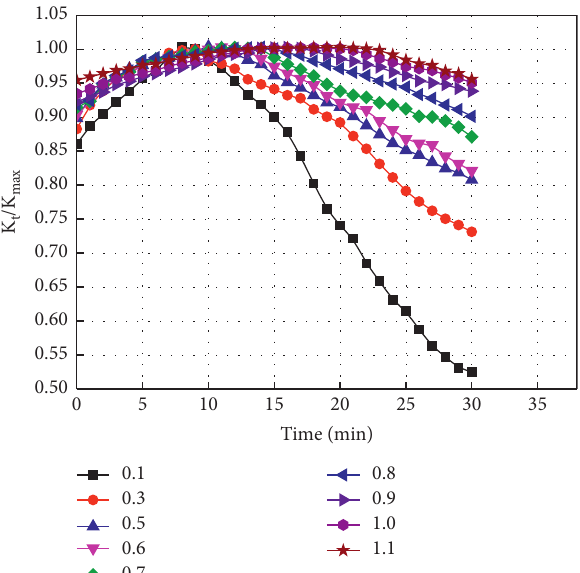
Figure 9: The curve of foam relative conductivity with time under different concentrations of xanthan gum. Table 5: The fitting linear equations of foam relative conductivity with time under different concentrations of xanthan gum. Surfactant mass